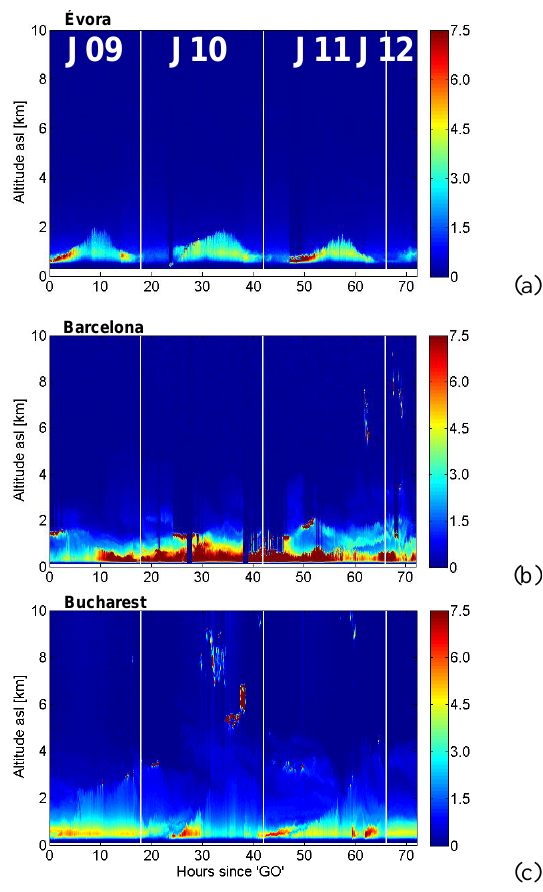
Figure 5. Quicklooks of the attenuated backscatter not corrected for the total transmissivity [a. u.] at 1064nm in (a) Évora, (b) Barcelona and (c) Bucharest. The white vertical lines indicate a change in the date. The attenuated backscatter is not a product of the SCC.